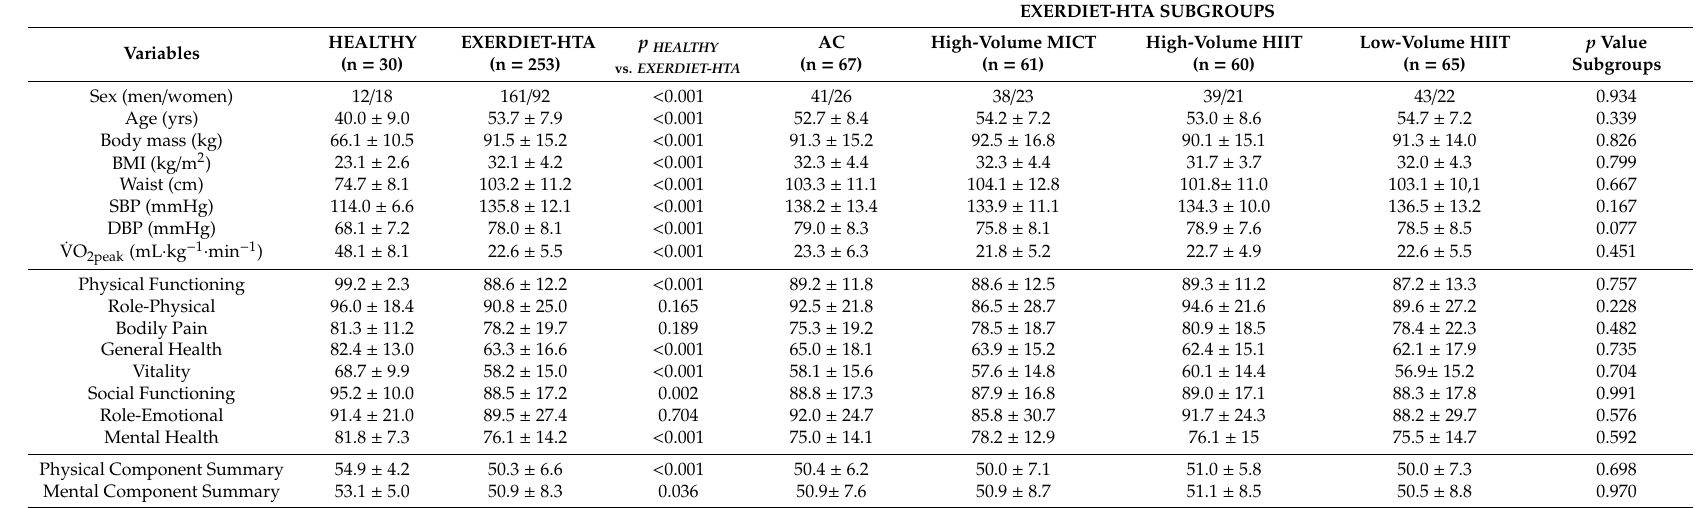
Table 1. Characteristics of the studied population and scores for eight variables of SF36 by group and subgroups at